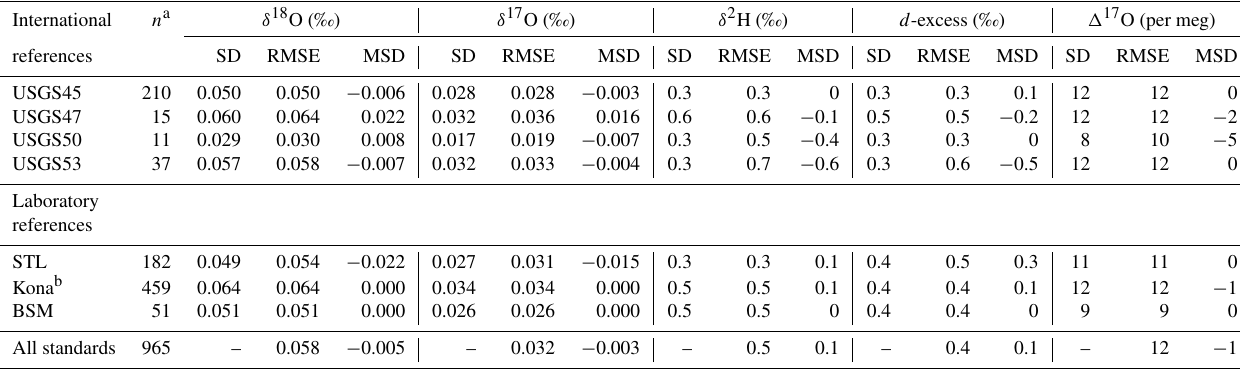
Table 2. Long-term performance of standard reference materials. Values for standard deviation (SD), root mean square error (RMSE), and mean signed difference (MSD) for all reference materials analyzed during the ∼ 2 year measurement period.